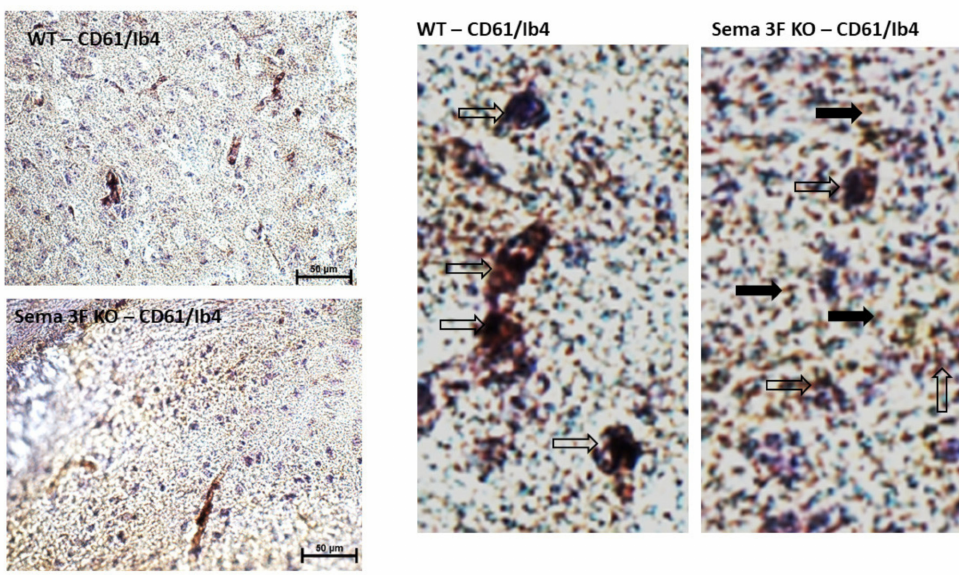
Figure 8. Localization of Platelets in Sema 3F KO vs. Wild Type Mice . Left panel: Representative immunohistochemical staining of platelet (CD61; brown), vascular (Ib4; purple), with blue hema- toxylin counterstain, in brain cortex from Sema 3F KO mice and their littermate wild type (WT) mice. The higher magnification of pictures shown in left panel indicate CD61 immunostaining mostly colocalizing with IB4 in WT mice. In contrast, Sema 3F KO tissue showed CD61 immunoreactivity partly colocalizing with IB4 (clear arrows) and partly out of IB4 (black arrows). The results show a significant increase in platelet infiltration in Sema 3F KO mice compared to more localized vascular platelet staining in the control WT